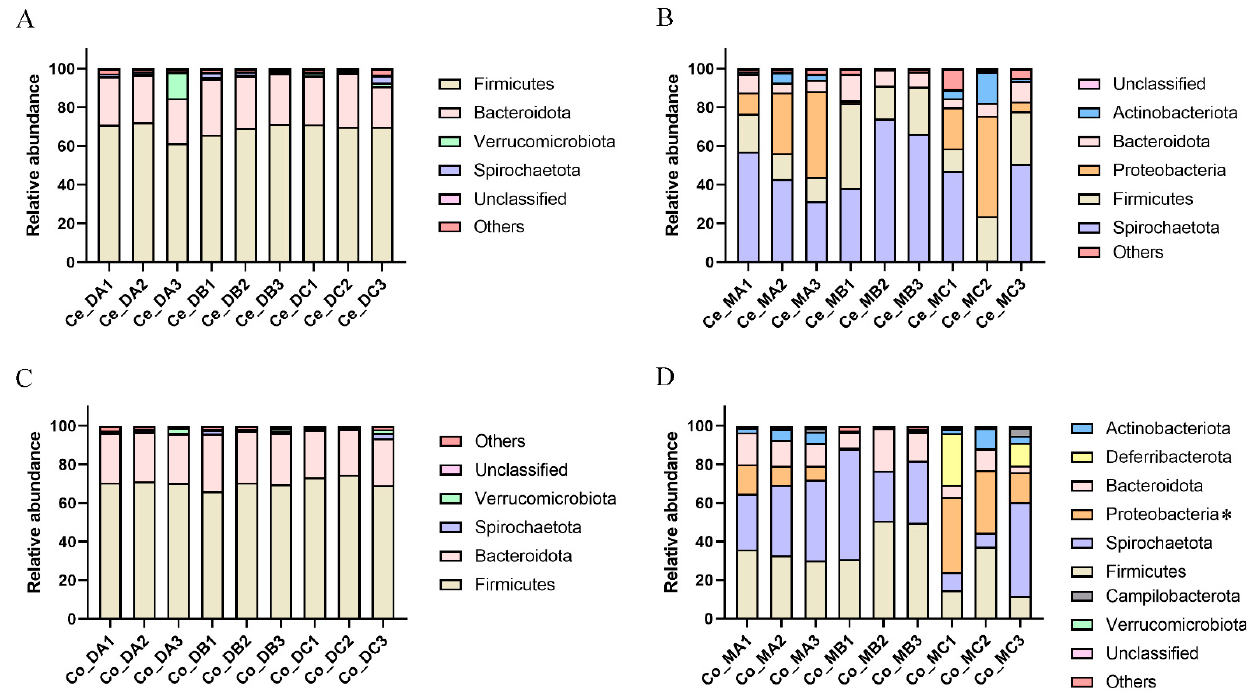
Figure 1. Effect of different nutritional levels on the abundance of bacteria in the phyla level ( A ) in the cecum digest, ( B ) cecum mucosa, ( C ) colon digest, ( D ) and colon mucosa. Bacteria with an abundance of less than 1% are classified as Others. “*” indicates 0.01 < p < 0.05.